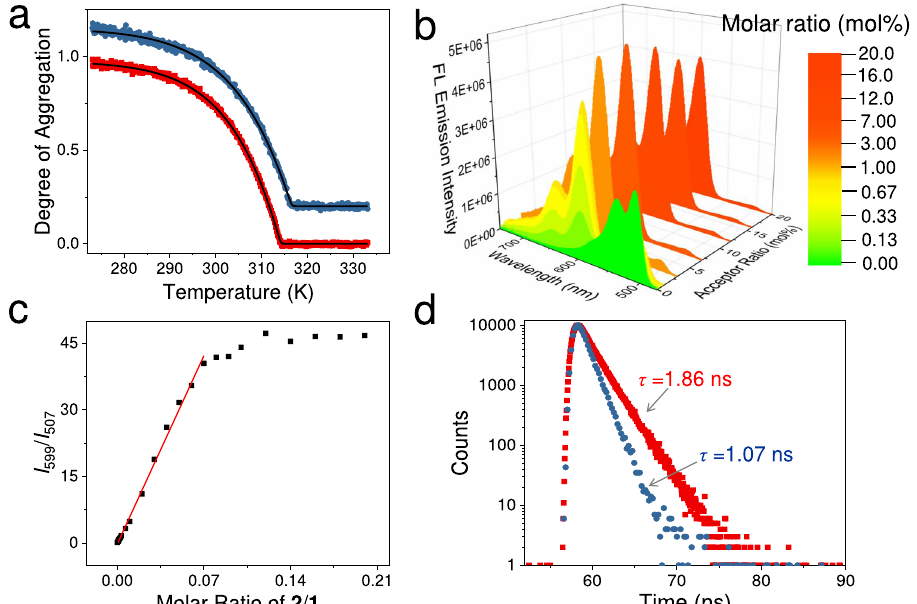
Fig. 4 Supramolecular copolymerization and energy transfer behaviors of the binary species 1/2. a CD melting curves of supramolecular homopolymers 1 ( c : 8.0 × 10 − 5 mol L − 1 in MCH, red line) and supramolecular copolymers 1 / 2 ( c : 8.0 × 10 − 5 mol L − 1 for 1 and 1.6 × 10 − 5 mol L − 1 for 2 in MCH, blue line) by tracking the CD intensities at 486 nm. In panels, the curves are shown with a 0.2 offset. Data and fi t are represented as colored and black lines, respectively. Both melting curves were fi tted by the mass balance model developed by Markvoort and ten Eikelder 47 . b Steady-state fl uorescent emission changes upon increasing the acceptor molar ratios. The concentration of 1 is kept at 8.0 × 10 − 5 mol L − 1 . Filling colors are de fi ned based on the CIE coordinates of the emission spectra. c Ratiometric plot of 2 upon direct excitation of 1 ( c : 8.0 × 10 − 5 mol L − 1 in MCH). The linear fi tting of the ratiometric plot is obtained by plotting the value of I 599 / I 507 versus the molar ratio of 2 . I 599 and I 507 denote the emission intensity of 2 at 599nm and 1 at 507 nm, respectively. d Fluorescence lifetime decay of supramolecular homopolymers 1 ( c : 8.0 × 10 − 5 mol L − 1 in MCH, red line) and supramolecular copolymers 1 / 2 ( c : 8.0 × 10 − 5 mol L − 1 for 1 and 1.6 × 10 − 5 mol L − 1 for 2 in MCH, blue